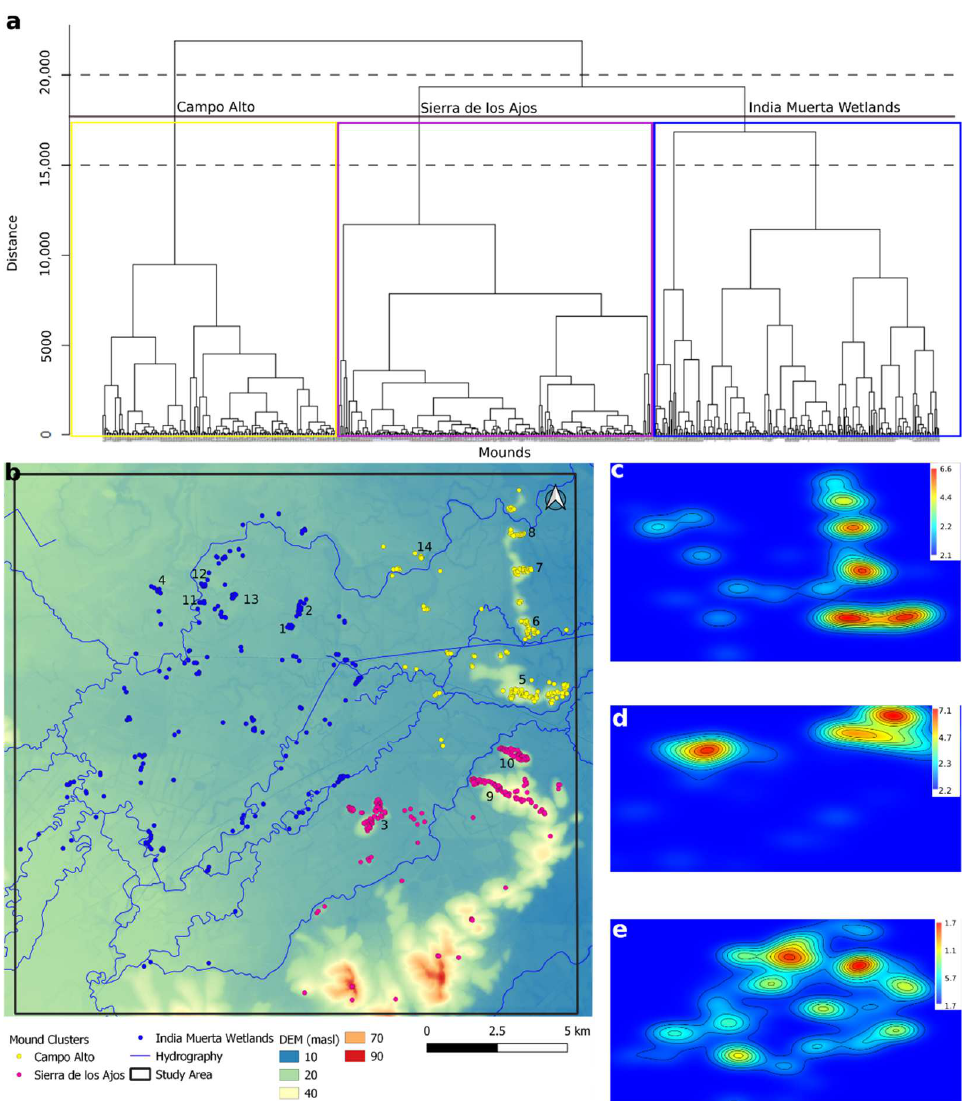
Figure 6. Results of the distributional analysis of mounds ( a ). Dendrogram resulting from the hclust algorithm, complete method in Rstudio. The possible cutoffs are shown for the scale of work by the dotted line, while the continuous black line shows the selected cutoff. ( b ) Spatial distribution of the clusters resulting from the selected cutoff of the dendrogram. DEM abbreviation correspond to Digital Elevation Model. ( c ) Kernel model of the Campo Alto cluster, ( d ) kernel model of the Sierra de los Ajos cluster, ( e ) kernel model of the India Muerta wetlands cluster. The numbers indicate some of the most representative mound sites: (1) Isla de los Talitas, (2) Jaula del Tigre, (3) Mal Abrigo, (4) García Ricci, (5) Campo Alto, (6) Cabrera B, (7) Cerro Alto, (8) El Solitario, (9) Los Ajos, (10) Colina